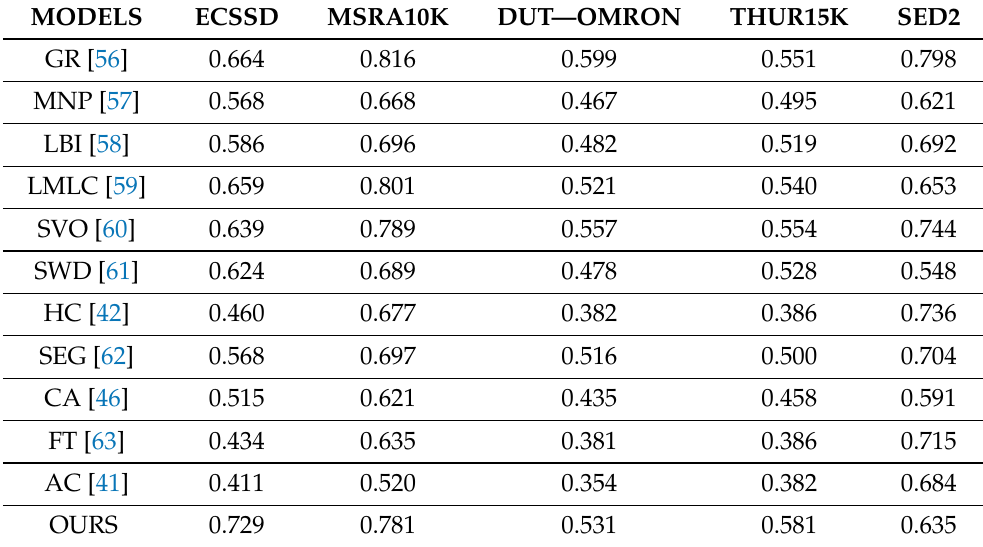
Table 3. Our model’s F β measure results compared with some state-of-the-art models from Borji et al. [48].